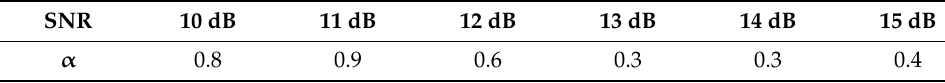
Figure 14. The BER performance versus α for the second model. Table 6. The optimal value α corresponding to